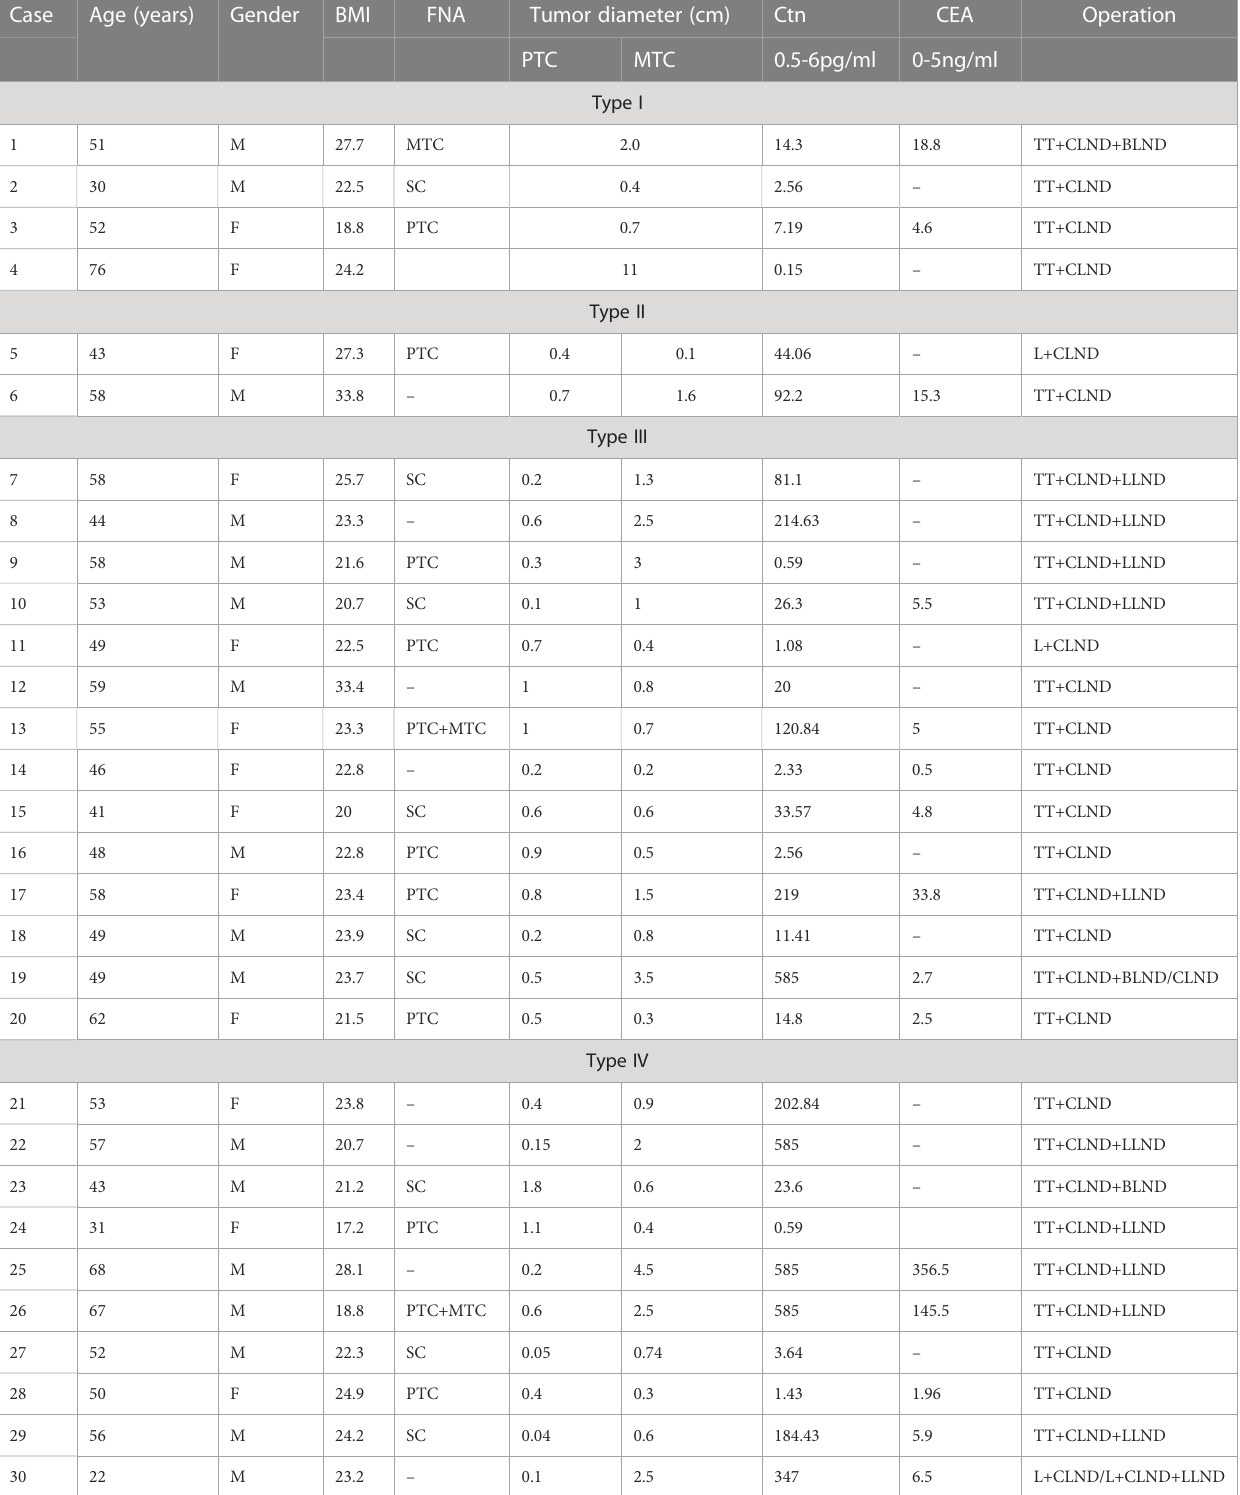
TABLE 1 Preoperative basic information of 30